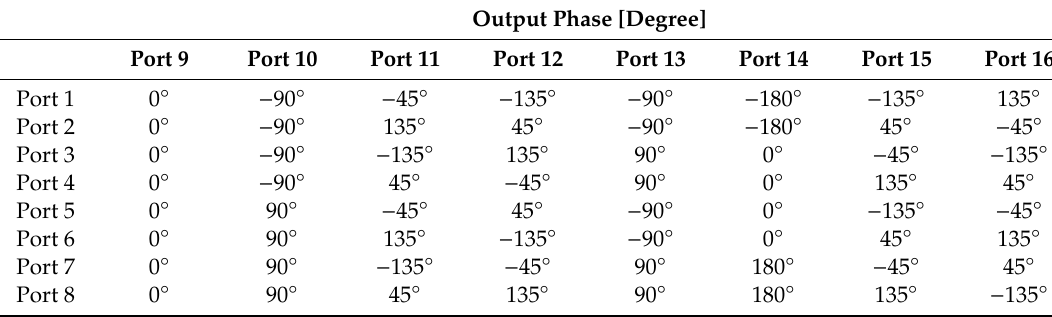
Figure 3. Structure of the 8 × 8 Butler matrix. Table 1. Phases associated with the selected port of the 8 × 8 Butler matrix.